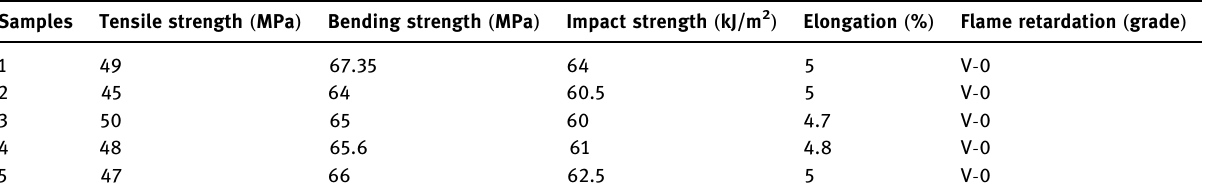
Table 3: Mechanical properties of the plates treated with the “ supporting mold ”